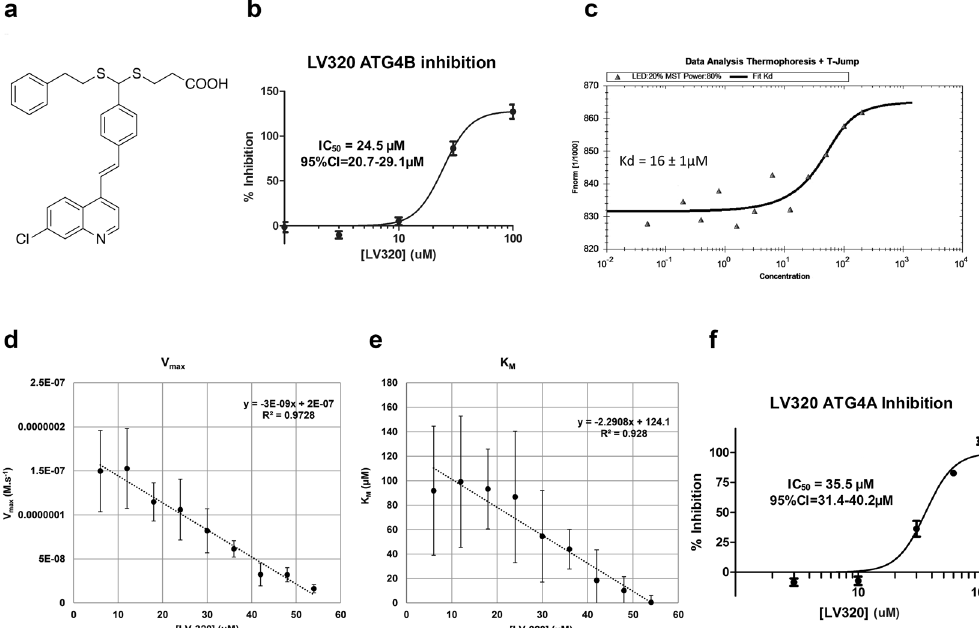
Figure 4. LV-320 arose from the SAR study and binds ATG4B. ( a ) Structure of LV-320 . ( b ) IC 50 of LV-320 in ATG4B cleavage assay using the fluorescent peptide pim-FG-PABA-AMC as substrate; n = 3; error bars, SEM ( c ) Binding of LV-320 with ATG4B determined by MST. (n = 3) ( d ) and ( e ). LV-320 depresses both the V max ( d ) and K M ( e ) in an ATG4B enzymatic assay with a fluorogenic peptide substrate, concordant with an uncompetitive mode of inhibition. Error bars, SEM. Experiments were performed with technical quadruplicates and representative biological duplication. ( f ) IC 50 of LV-320 in ATG4A cleavage assay using pim-FG-PABA- AMC as substrate. n = 4; error bars,